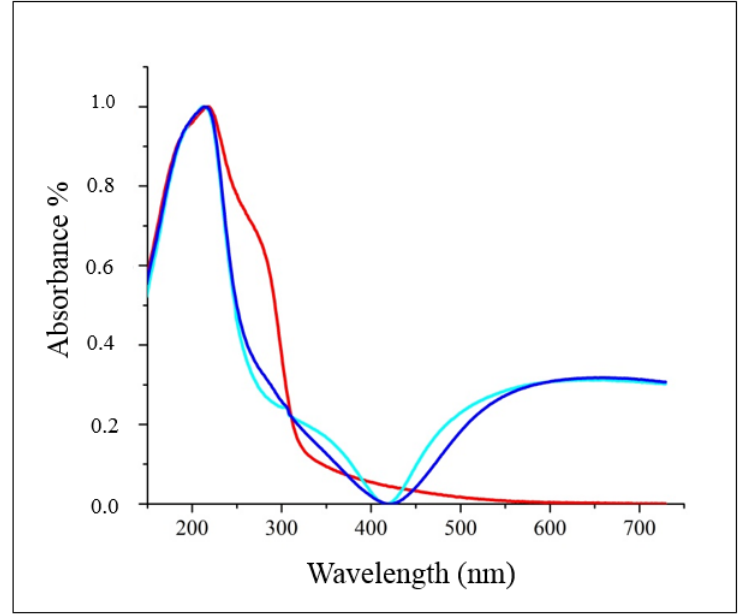
Figure 6. DR-UV-Vis spectra of TiO 2 -PHA (red line), pure HKUST-1 (sky blue line) and TiO 2 /HKUST- DR-UV-Vis spectra of TiO 2 -PHA (red line), pure HKUST-1 (sky blue line) and 1 (blue line). TiO 2 /HKUST-1 (blue line).